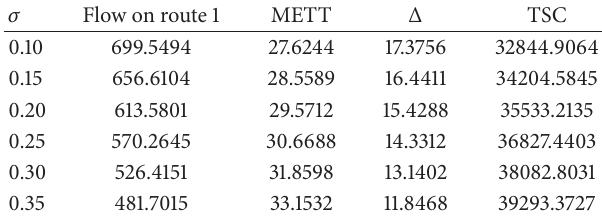
Table 9: Results with different 𝜎 at